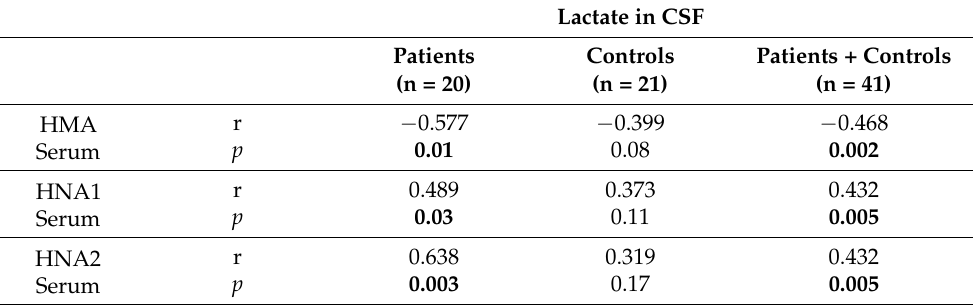
Table 4. Non-parametric partial correlations of albumin redox fractions in serum with lactate in CSF of patients (RRMS and PPMS) and controls (control variable: age at